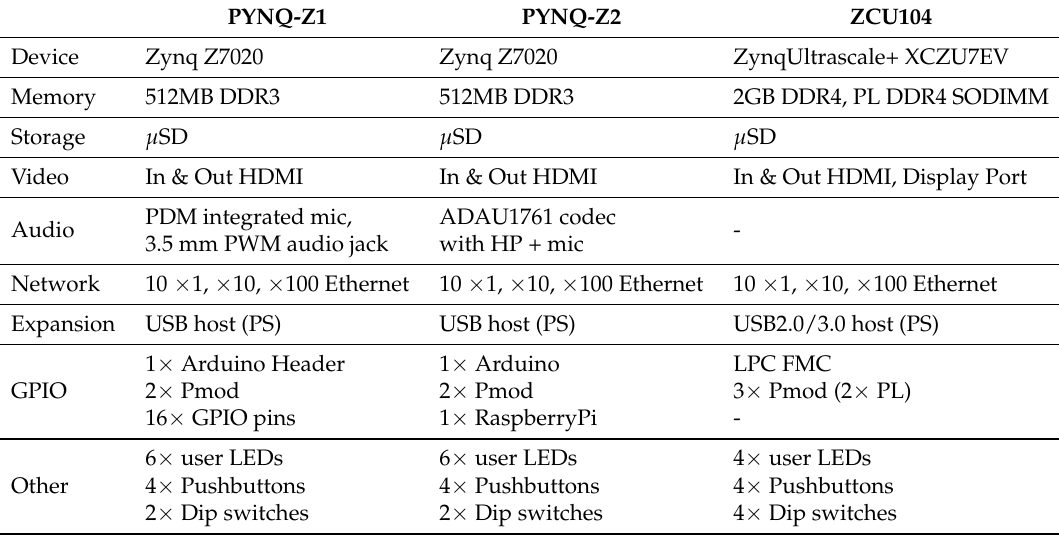
Table 12. Comparisons between various versions of Pynq